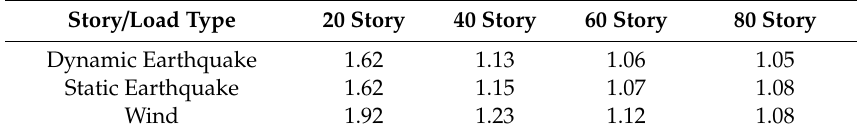
Table 5. Average of positive shear lag factor among three types of plan geometry for each